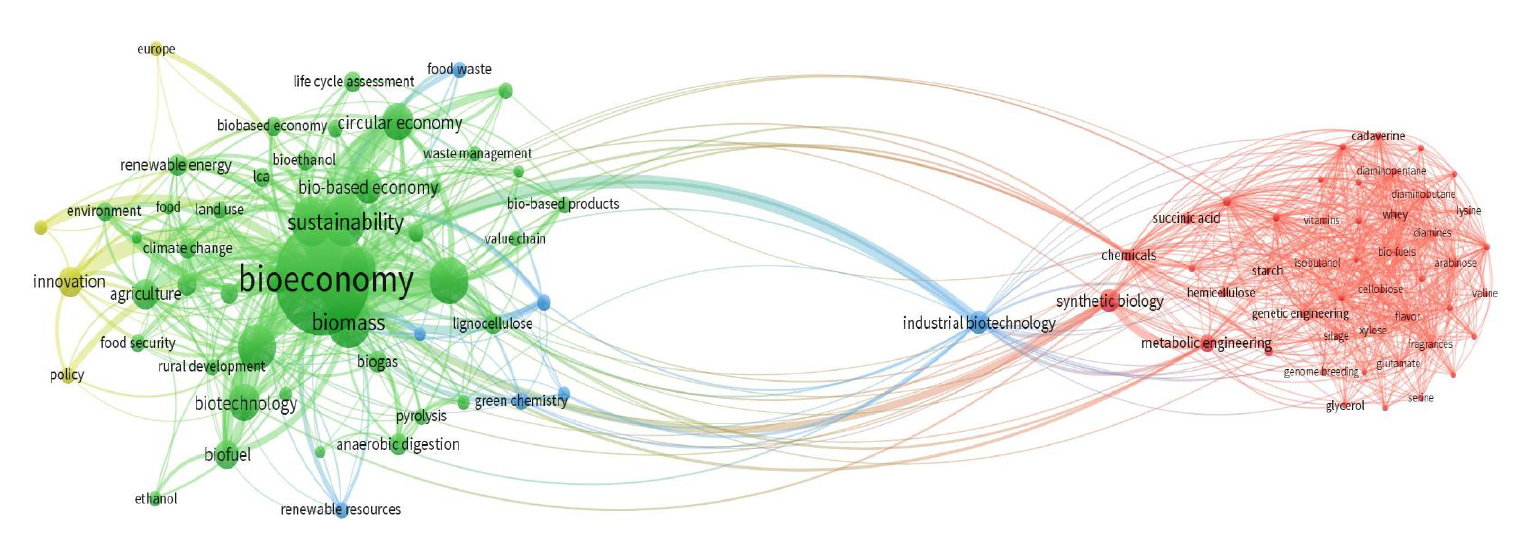
Fig. 3. Top 100 keywords with strongest links from SCOPUS scientific publications about bioeconomy related with selected 24 bioeconomy affecting